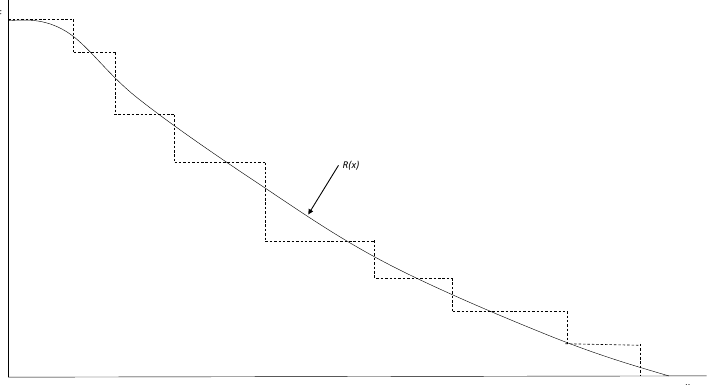
Figure 1. Schematic description of staircase and continuous risk functions based on e.g., Kaplan and Garrick